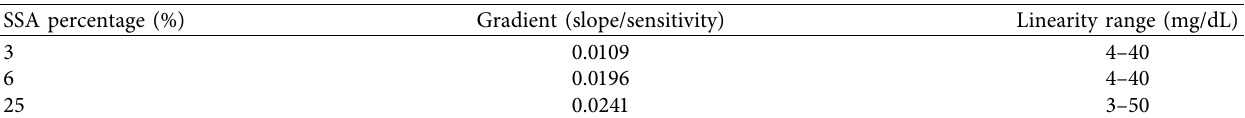
Table 2: Analytical sensitivity (gradient) and linearity range of 3%, 6%, and 25% sulfosalicylic acid for albumin standard curves, where the protein concentrations were assessed in the modified SSA quantitative